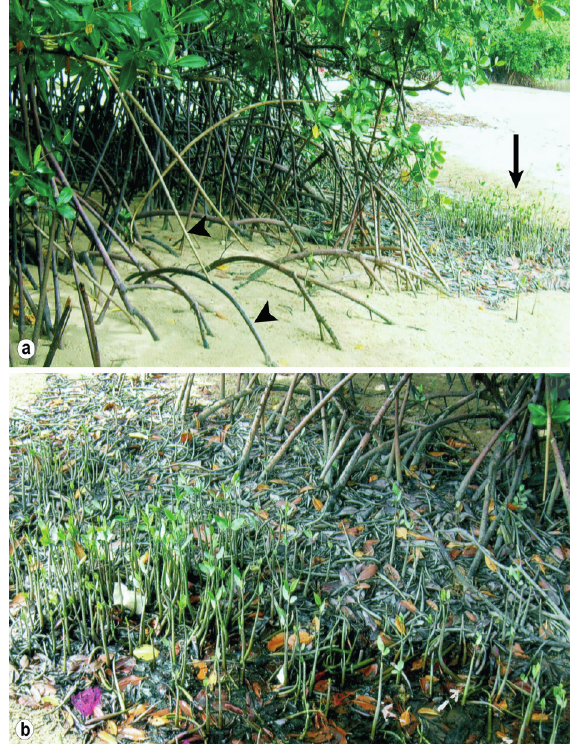
Figure 1 - (a-b): Rhizophora mangle in Mangrove on sandy soil at Porto de galinhas (Pernambuco, Brazil). Aerial branches with rhizophores (solid triangles) with numerous plantlets (at the arrow head), magnified in b